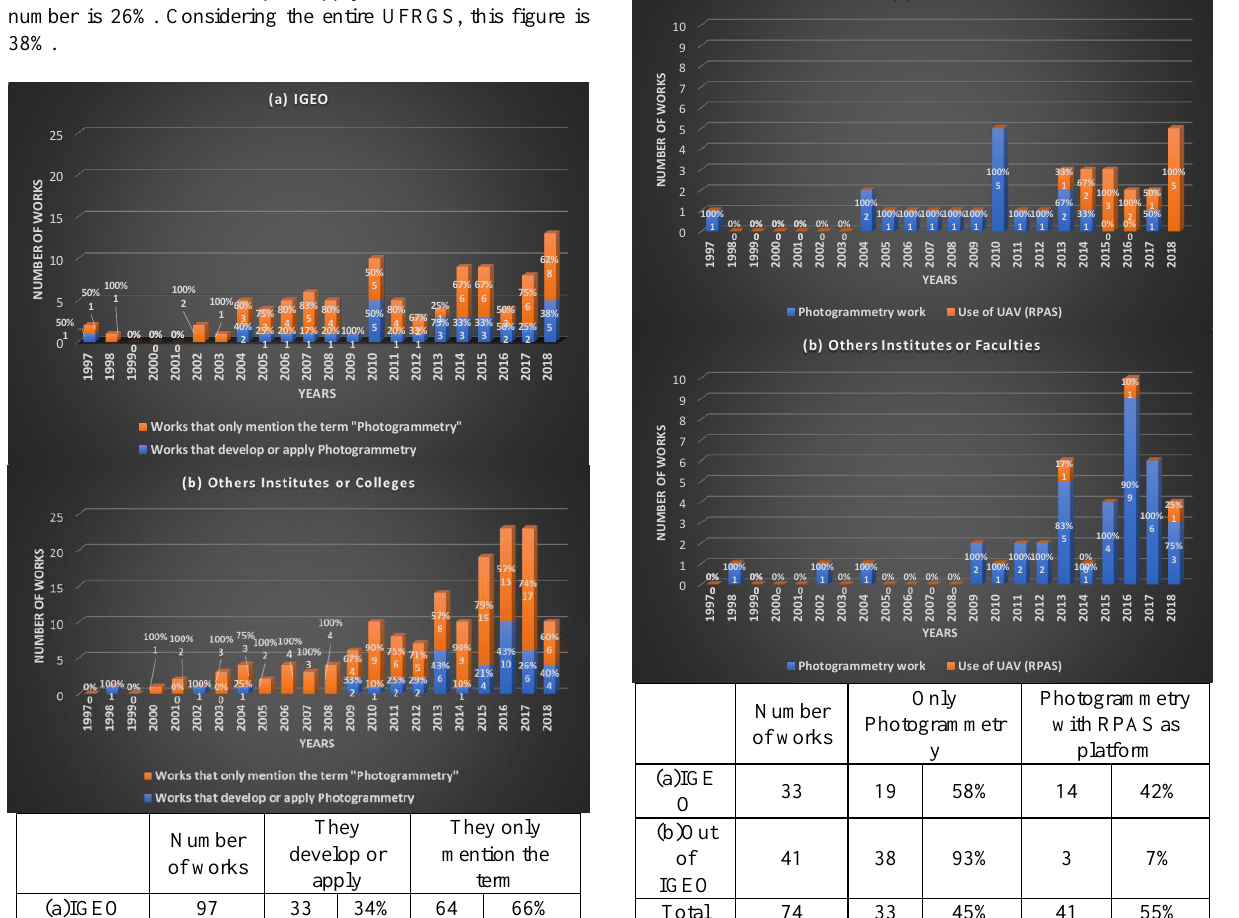
Figure 4. Works that develop or apply Photogrammetry using RPAS as one of the acquisition platforms: (a) IGEO; (b) Other institutes and Colleges.